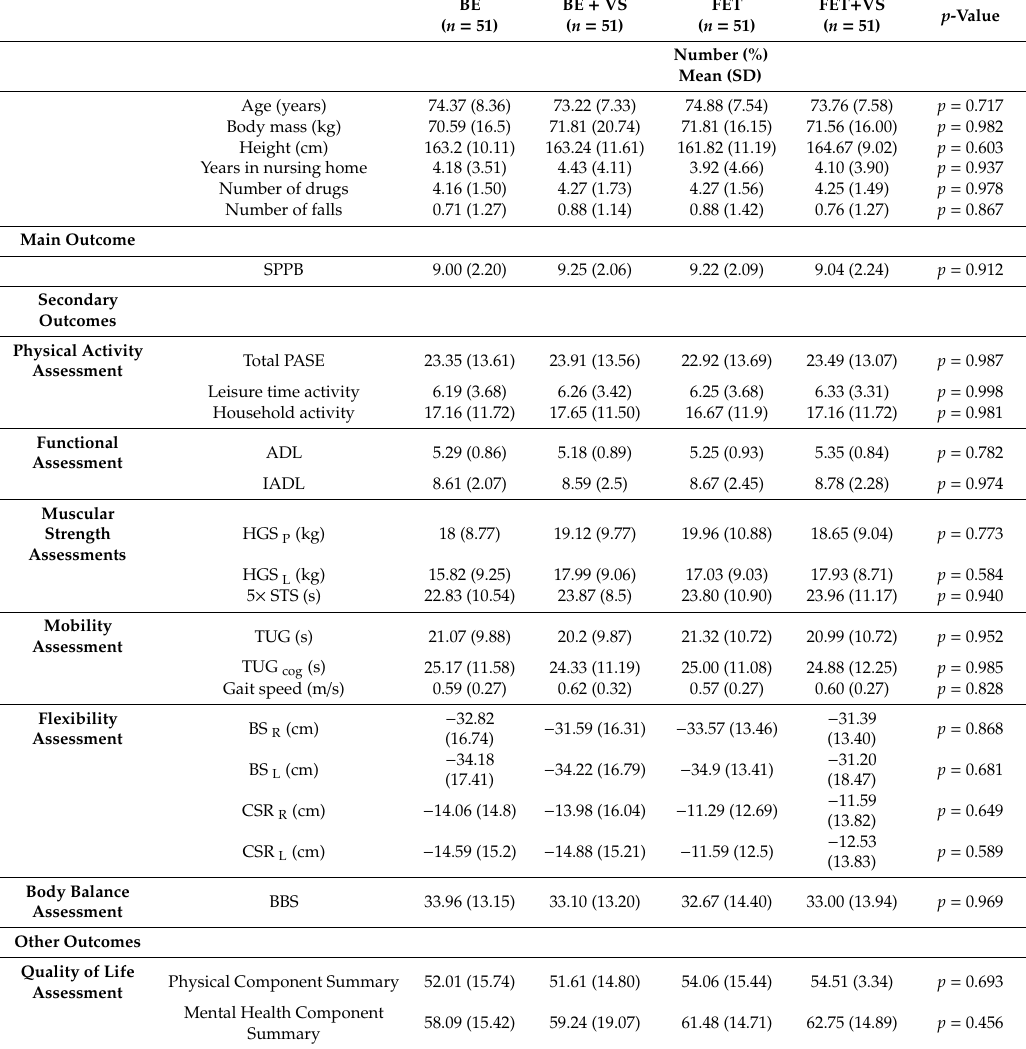
Table 1. Sociodemographic and clinical characteristics of the